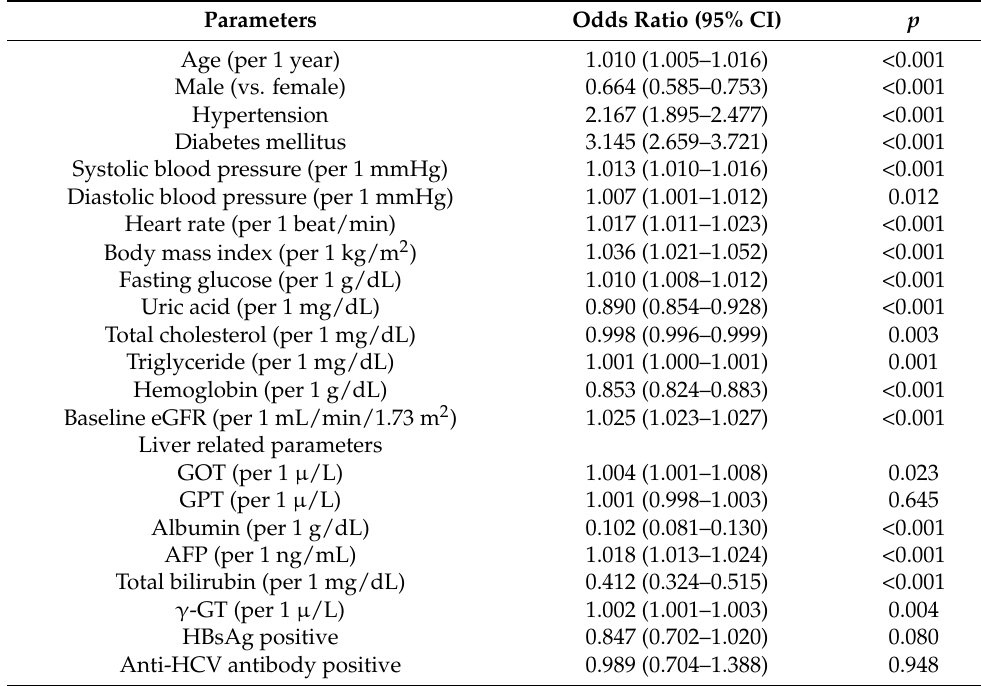
Table 2. Parameters associated with an eGFR decline of ≥ 25% in univariable binary logistic analysis in all study participants ( n = 27,116).